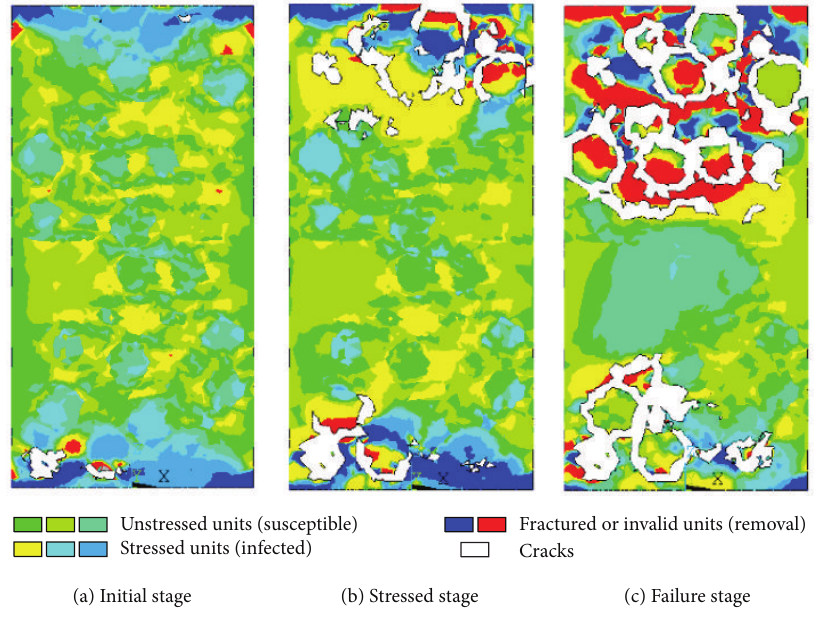
Figure 1: Damage propagation process and different units based on microlevel